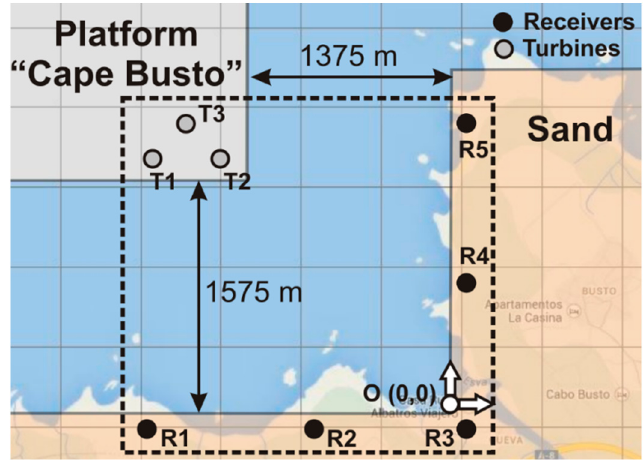
Figure 4. Sources and receivers’ positions for the Cape Busto location.